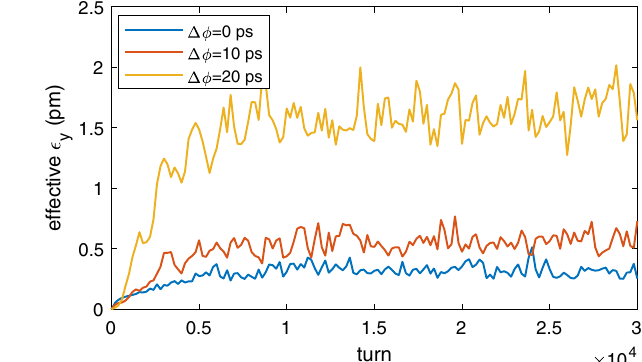
FIG. 10. Growth of effective emittance for the regular beam due to bunch arrival time shifts. There is no x - y linear coupling in the lattice